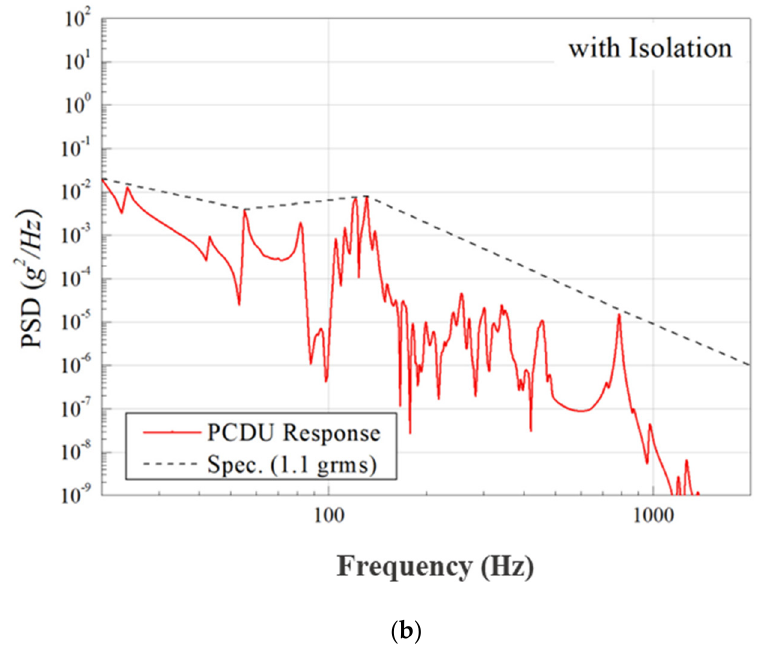
Figure 18. Generated random vibration specification of the power control divide unit (PCDU) with respect to both with and w/o the whole spacecraft vibration isolation of the VFOD [( a ): w/o isolation, ( b ): with isolation].